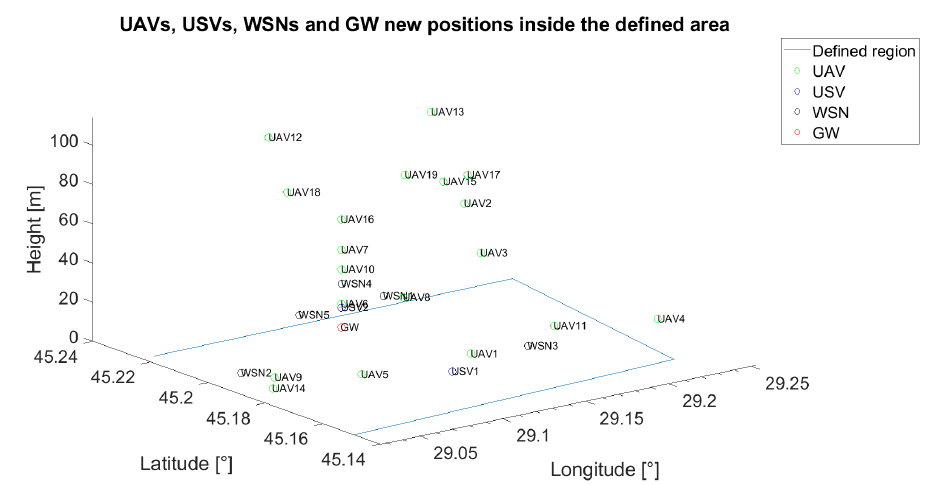
Figure 13. Final positions after applying the algorithm. Scenario depicted in Table 10, ρ = 0.2.